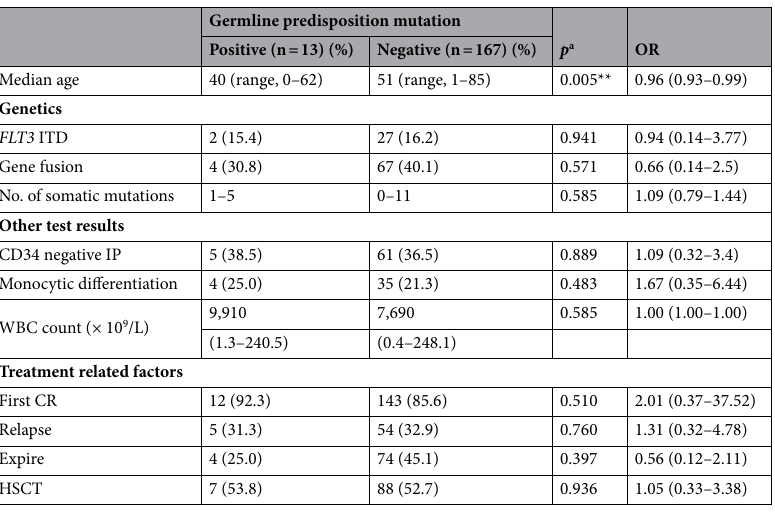
Table 2. Characteristics of patients with germline predisposition mutation. OR odds ratio, ITD internal tandem duplication, No number, IP immunophenotype, CR complete remission, HSCT hematopoietic stem cell transplantation. a Fisher’s exact test was used. ** P ≤